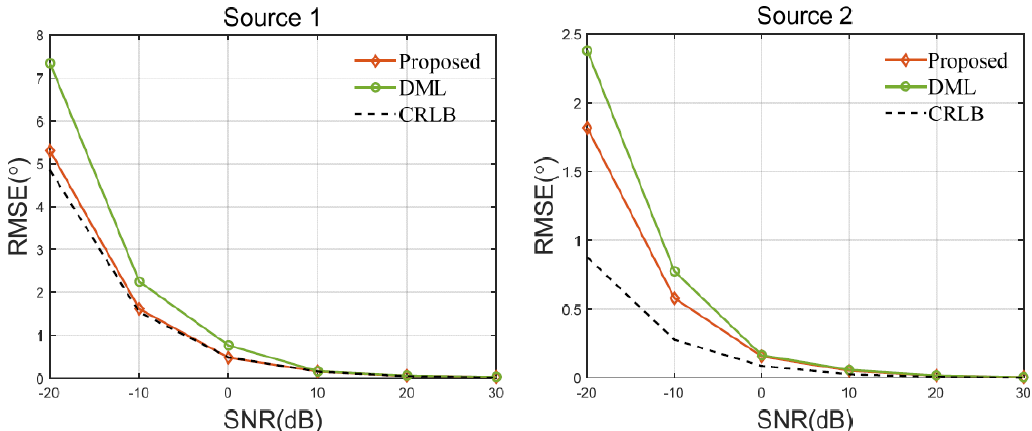
Figure 3. RMSE and CRLB versus SNR of the estimated parameter ϕ .